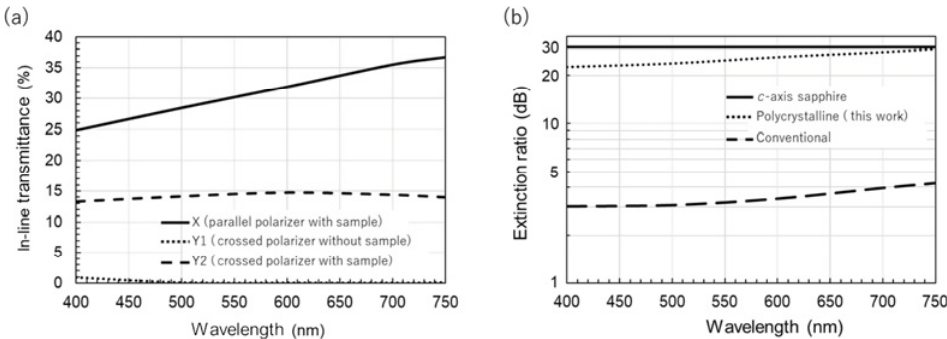
Fig. 5 (a) In-line transmittance of conventional ceramics measured with conditions X, Y1, and Y2 using two polarizing plates. (b) Comparative extinction ratio values for c -axis sapphire single crystals and conventional and advanced alumina ceramics in visible wavelength